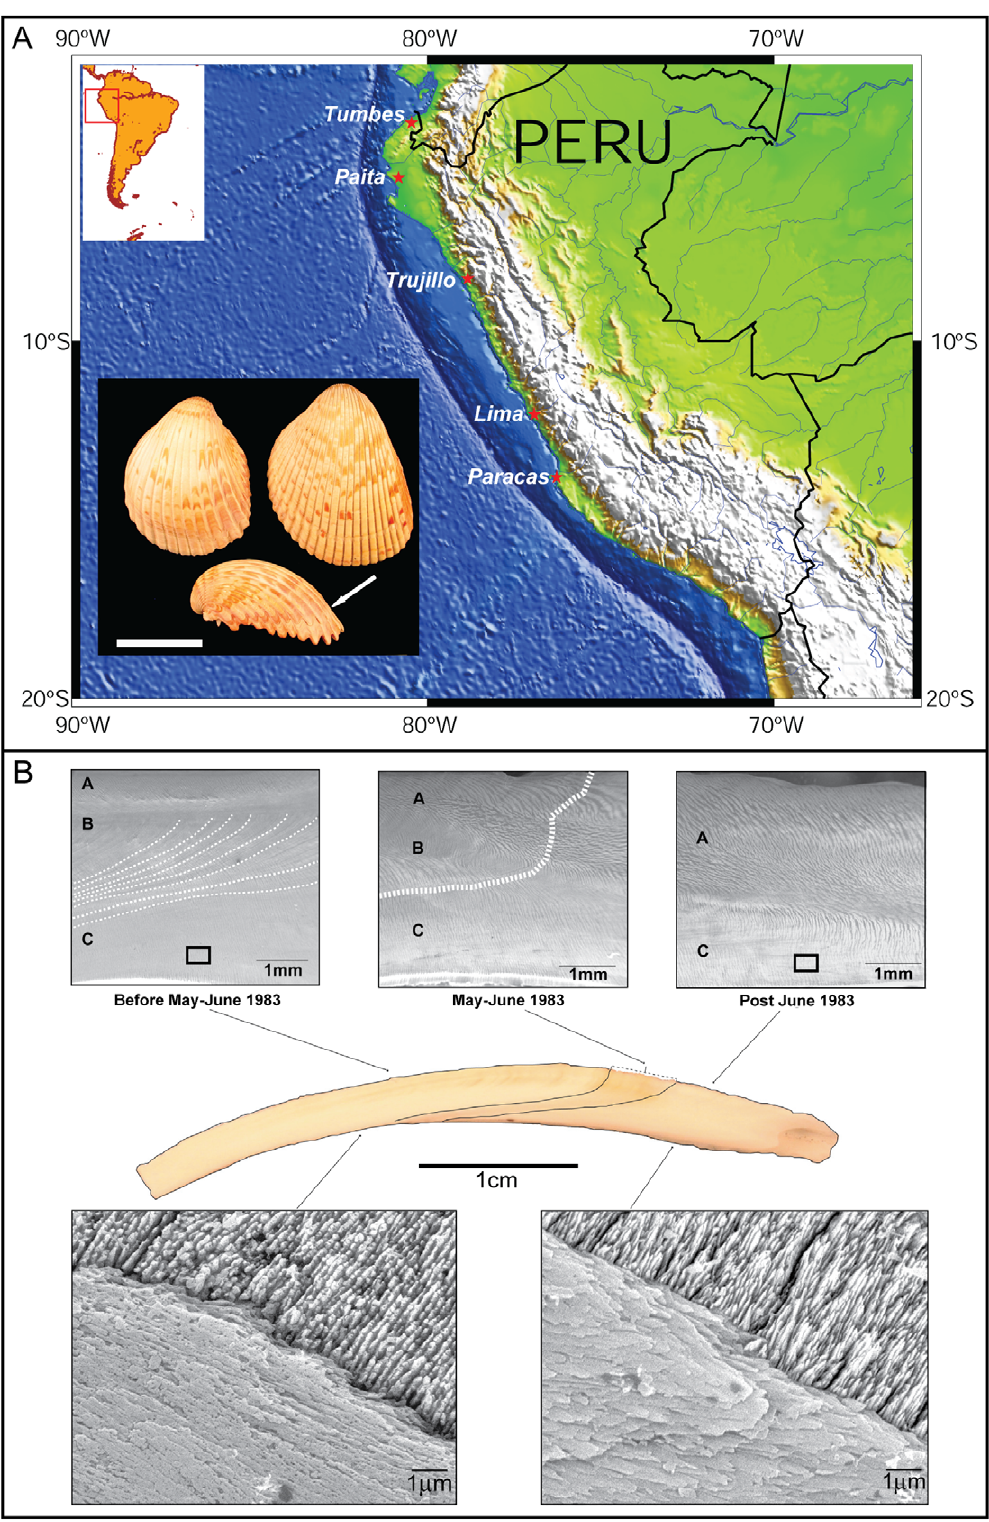
Figure 1. Map with collection site of T.procerum specimens and shell microstructures related to 1982–1983 El Nin˜o event. (A) Shell collection site at Paracas in the coast of Peru and an image of T. procerum shells (insert) [white arrow indicates the location of the scar; scale=4 cm]. (B) SEM images of shell regions in specimen 2TP4-2 precipitated during (before May–June 1983; A, B and C layers, with growth lines indicated by dashed lines), at the scar (May–June 1983), and after (after June 1983; A and C layers) El Nin˜o, and a detail of primary and secondary lamellae within a cross-lamellar aragonite structure, showing differences in the organic matrix components during and after the event.